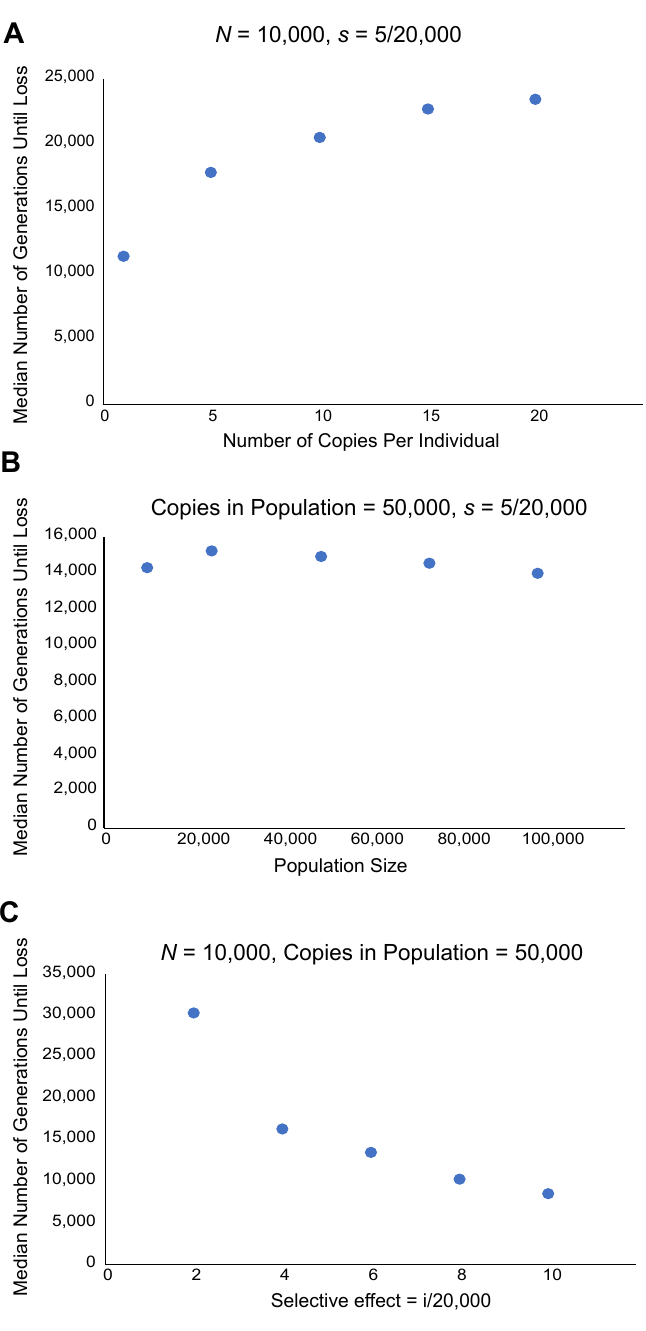
Figure 1. Dynamics of stochastic loss. N is the diploid population size and s is the selection coe ffi cient acting against single insertions. All simulations were performed by simple binomial sampling of